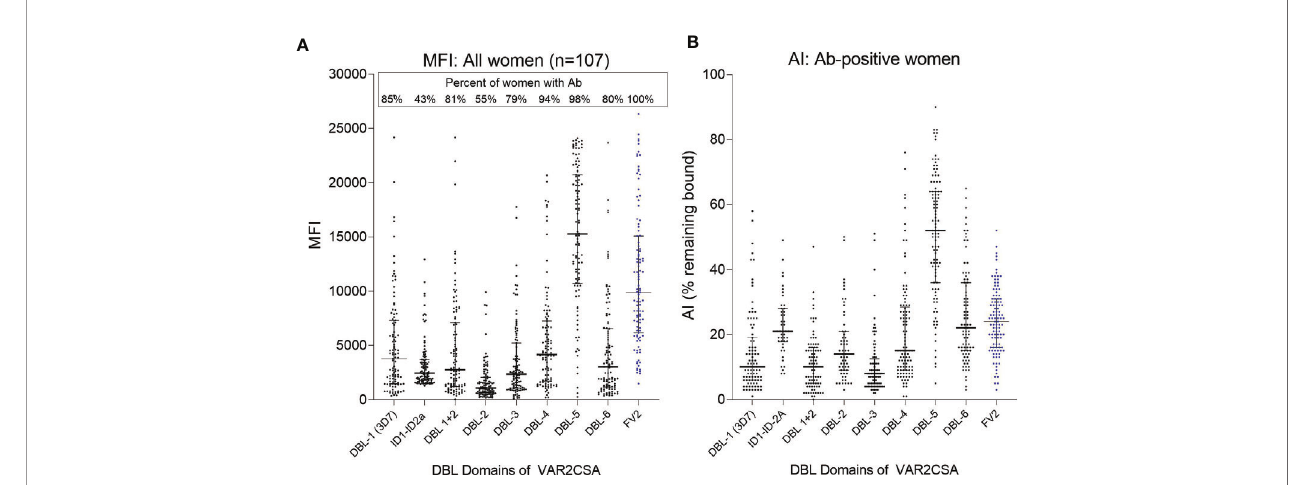
FIGURE 7 | Antibody MFI and AI to different regions of VAR2CSA. Plasma samples from 107 women were screened for Ab avidity against DBL1 (3D7 line), the FCR3 lines of ID1-ID2a, the DBL2 through DBL6, and FV2. (A) MFI for the 107 samples. Horizonal lines represent medians and IQR. (B) AI for women who had Ab against each of the domains (sample size: DBL1 n = 91; ID1-ID2a n = 46; DBL1+2 n = 87; DBL2 n= 59; DBL3 n = 84; DBL4 n = 101; DBL5 n = 105; DBL6 n = 86; FV2 n = 107). Horizontal lines represent medians and IQR.